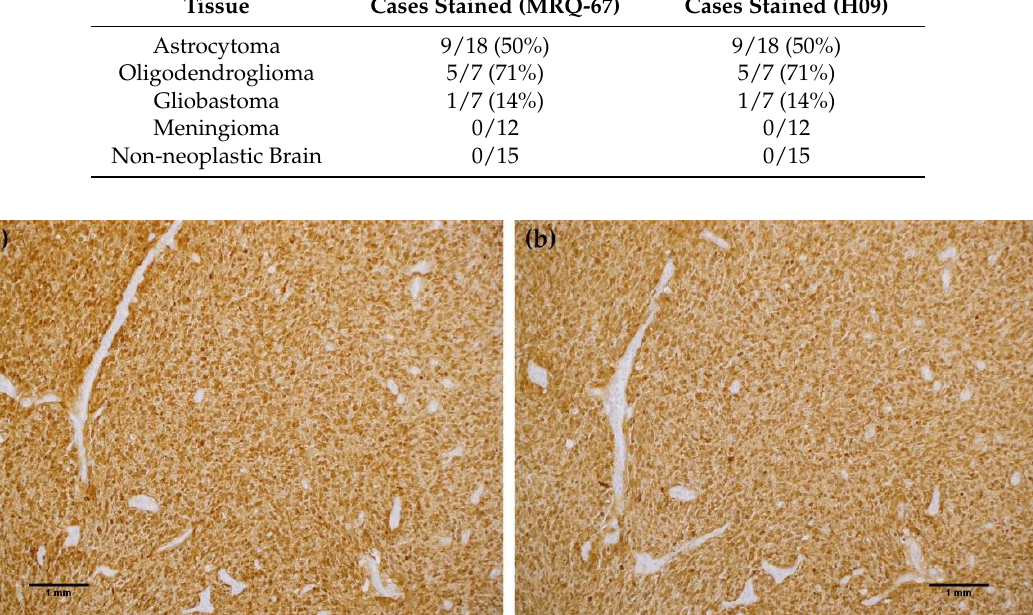
Figure 2. Comparison immunohistochemistry (IHC) staining results with MRQ-67 and H09 in astrocytoma: ( a ) Strong, diffuse cytoplasmic and weak nuclear labeling of tumor cells with MRQ-67 in a case of anaplastic astrocytoma (100×); ( b ) Equivalent cytoplasmic and nuclear staining of tumor cells with H09 in the same case of astrocytoma (100×).